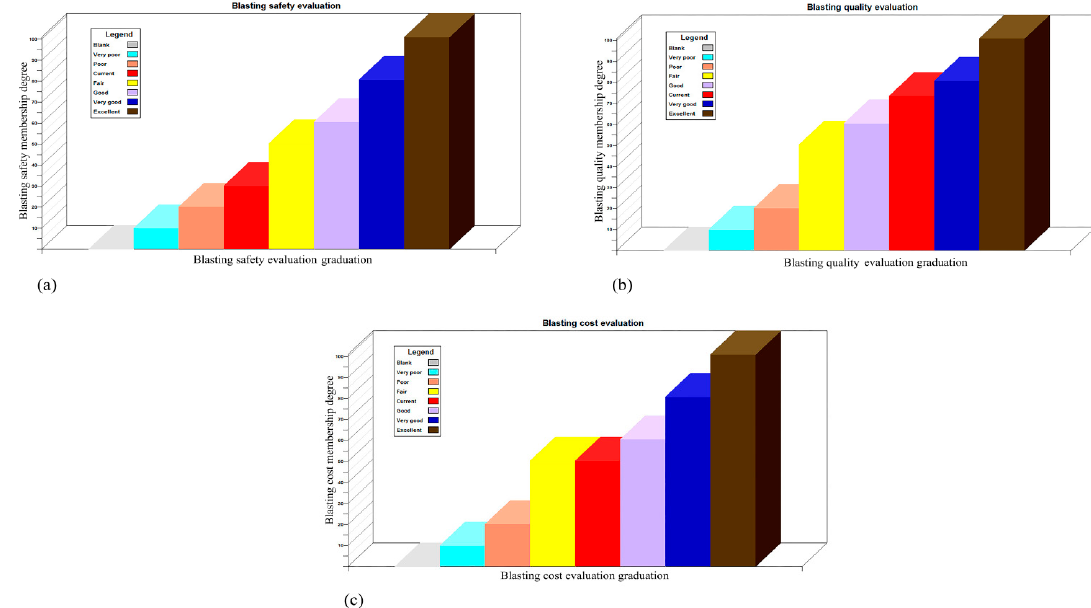
Figure 7. Histogram of blast effect evaluation by first-level mathematical model: ( a ) blasting safety; Figure 6. Histogram of blast e ff ect evaluation by first-level mathematical model: ( a ) blasting safety; ( b ) blasting quality; ( c ) blasting cost. ( b ) blasting quality; ( c ) blasting cost.